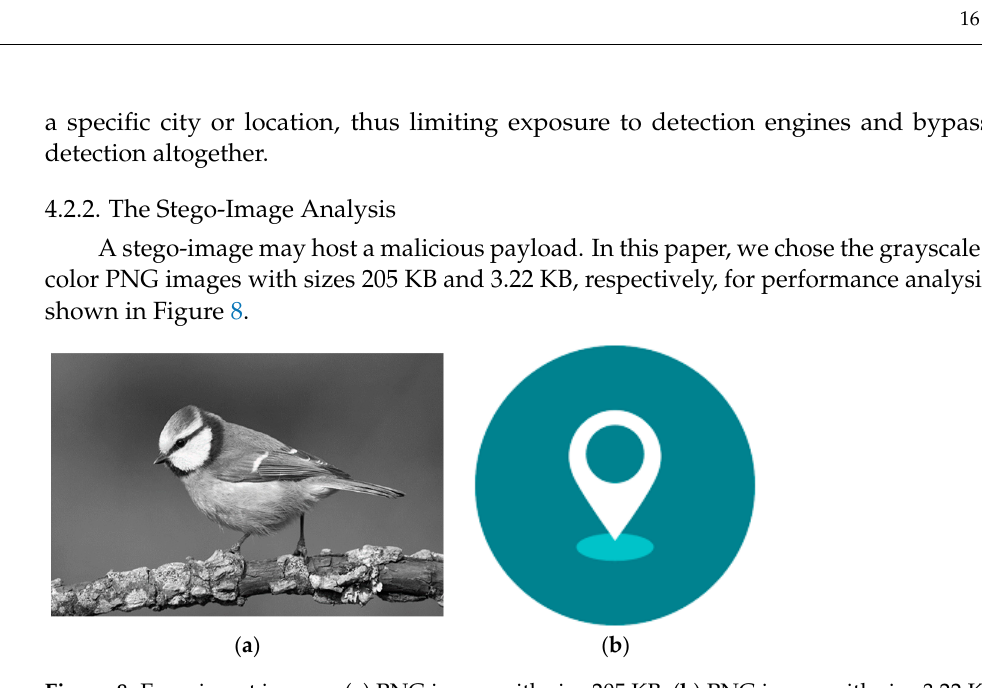
Figure 7. Comparison analysis of the WPS.